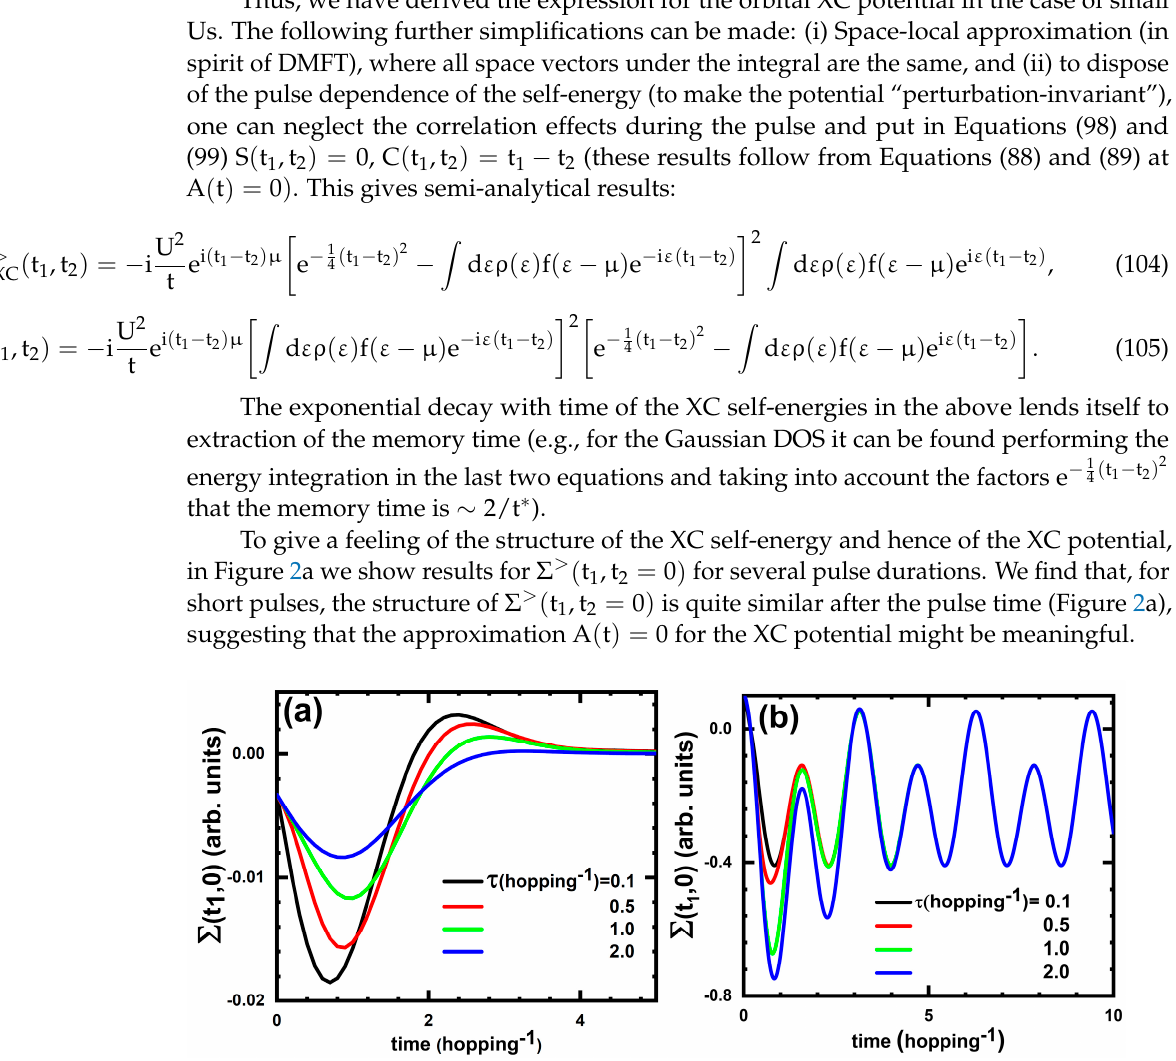
Figure 2. The real part of the greater XC self-energy for several values of the pulse duration: ( a ) small U (A = 1, U = 2, μ = 1, wherever it is appropriate, the units are hopping, or the inverse hopping) and ( b ) large U (A = 1, U = 6, μ = 2, n = 1.4, double occupancy D = 0.1), obtained using Equations (104) and (125), respectively.